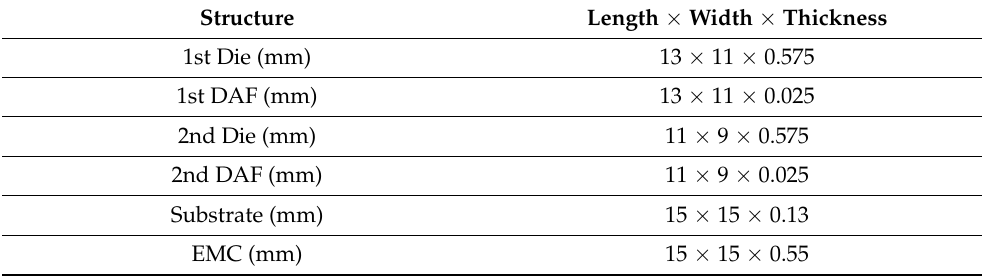
Table 2. Dimensions of TFBGA